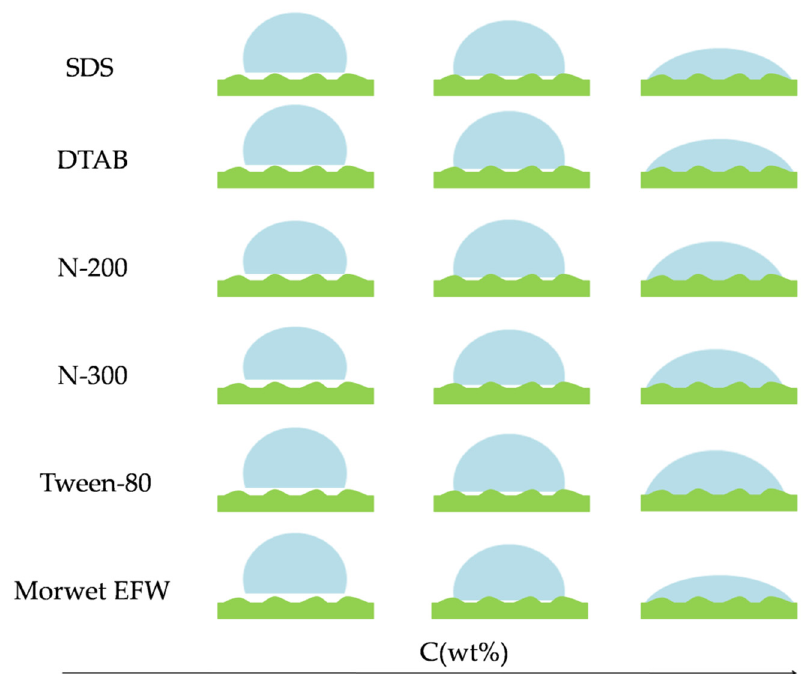
Figure 4. Optical images of contact angles on tea leaf surfaces according to the wetting stage.